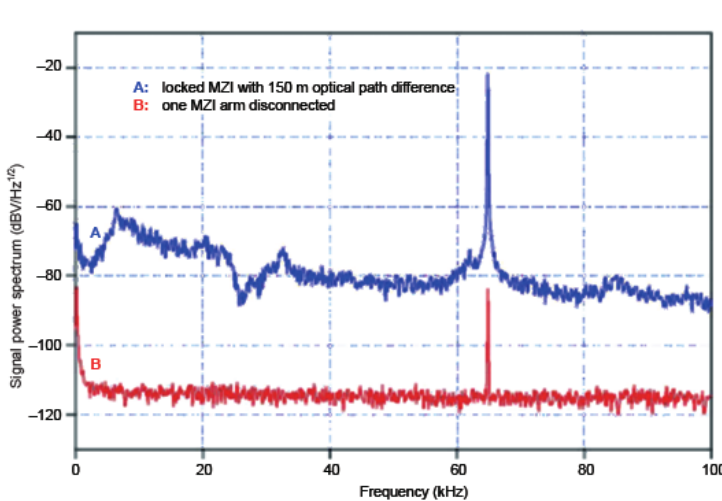
Fig. 7. Fiber laser spectral response to a 65 KHz test tone (OPD = 150 m). Top (A): the fiber laser response (output of the MZI) to a 65 kHz loud-speaker acoustic test note. Bottom (B): the laser output spectrum (without the MZI).